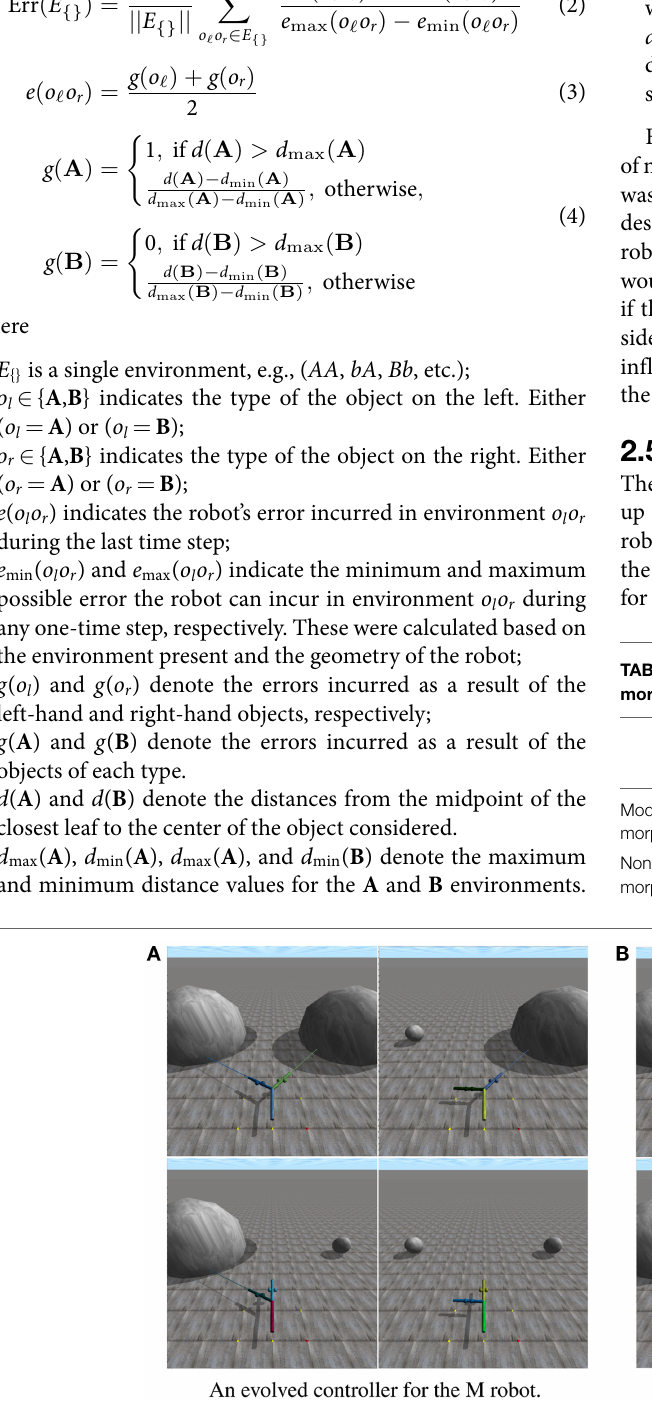
FIGURE 4 | The behaviors generated by two controllers that evolved to succeed in each of the four environments in the 2 (cid:2) 2 environment space . Lines emanating from the leaf branches represent the distance sensors embedded in each. Video of the robots can be found at https://www.youtube.com/ watch?v=t4gjv5nYeAA. (A) depicts an evolved robot with a modular morphology in each of the four environments in the 2 (cid:2) 2 environment space. (B) depicts an evolved robot with a non-modular morphology in each of the four environments in the 2 (cid:2) 2 environment space.